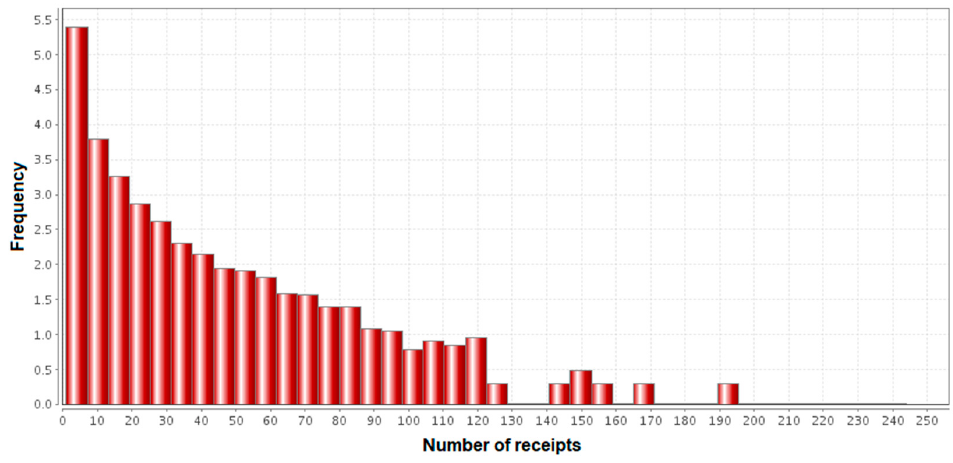
Figure 6. Schematic of the Augmented Data (AD) generation mechanism.